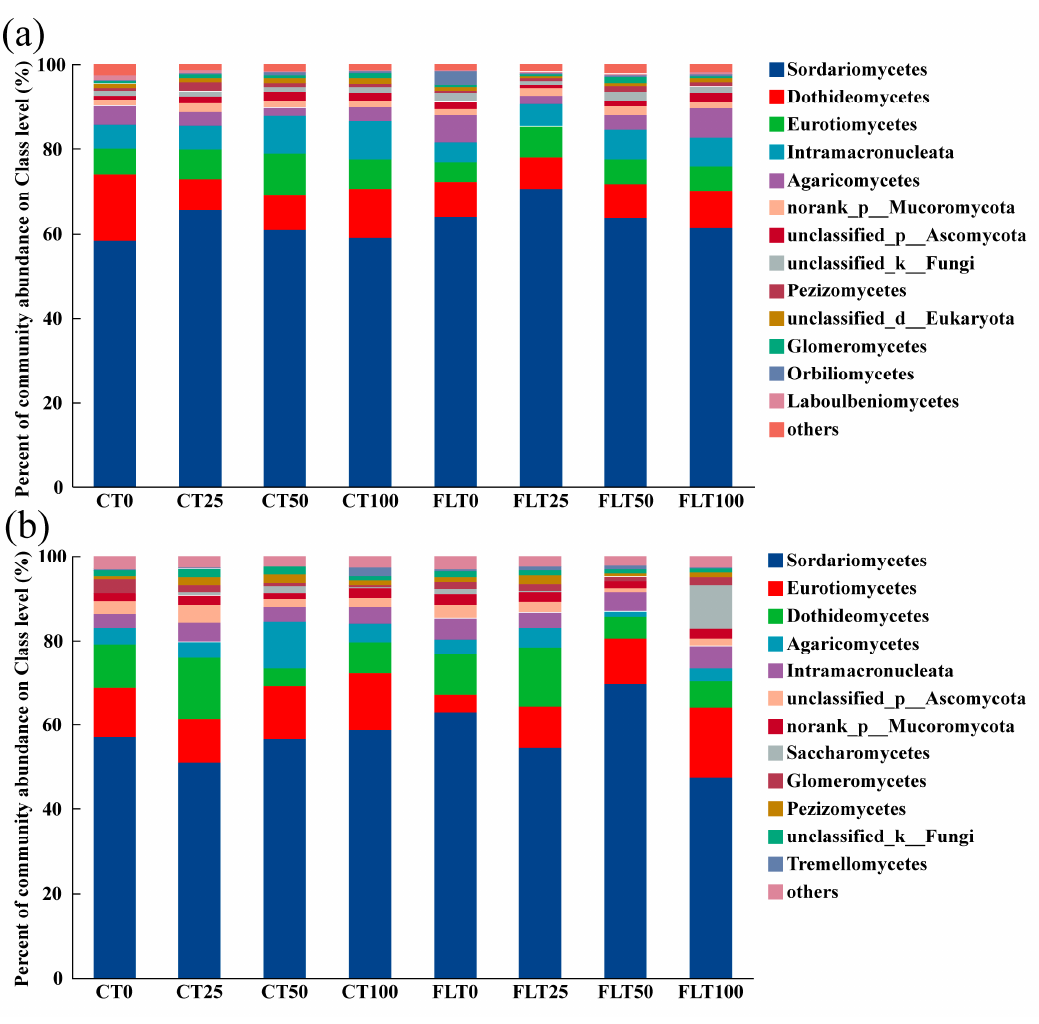
Figure 3. Relative abundances of the dominant fungal classes of cassava rhizosphere soil collected in 2019 ( a ) and 2020 ( b ), respectively. Different colors are used to represent the fungal classes with a relative abundance greater than 1%. “CT0, 25, 50, and 100” represent “0, 25%, 50%, and 100% N of conventional tillage”, respectively. “FLT0, 25, 50, and 100” represent “0, 25%, 50%, and 100% N of Fenlong tillage”, respectively.